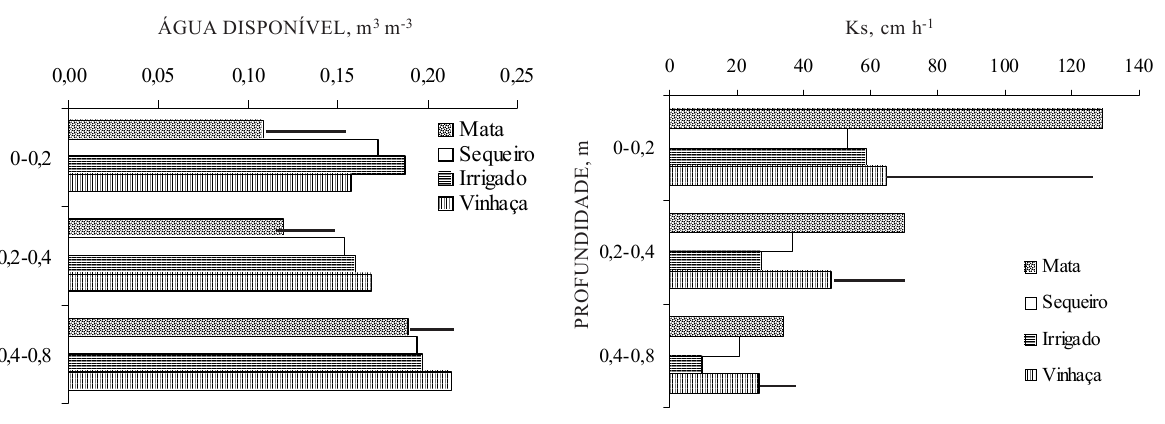
entre Figura 3. Condutividade hidráulica saturada (Ks), m considerando os sistemas de uso e manejo nas profundidades estudadas. Linhas horizontais indicam a diferença mínima significativa pelo teste de Tukey (5 %) e comparam médias dos sistemas de uso e manejo em cada profundidade.